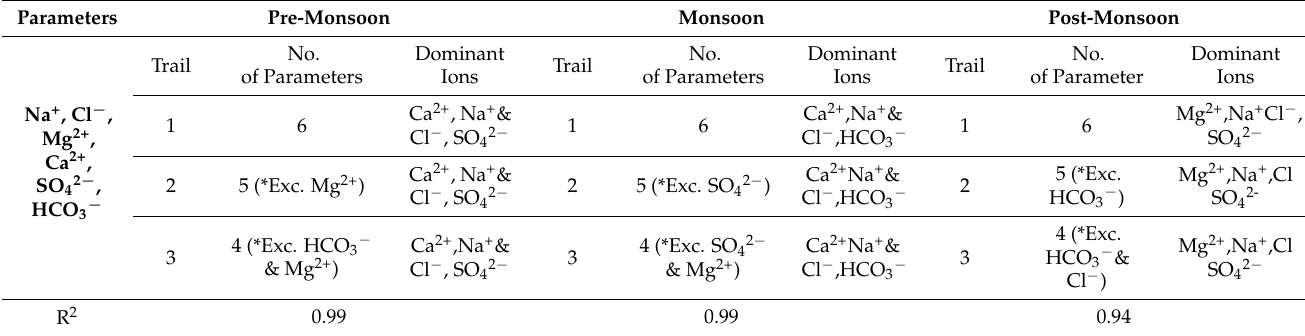
Table 1. Different trails and dominant ion of each trail for all three seasons through Multiple Regression Analysis. Parameters Pre-Monsoon Monsoon